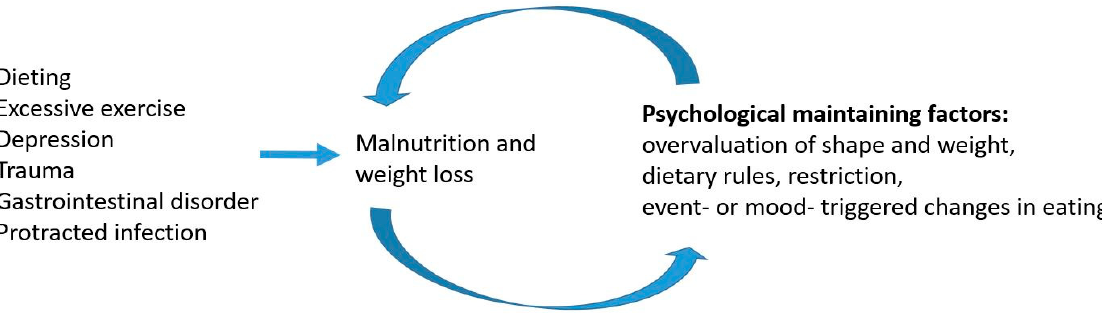
Figure 1. Proposed model describing how AN develops and is maintained in a majority of patients